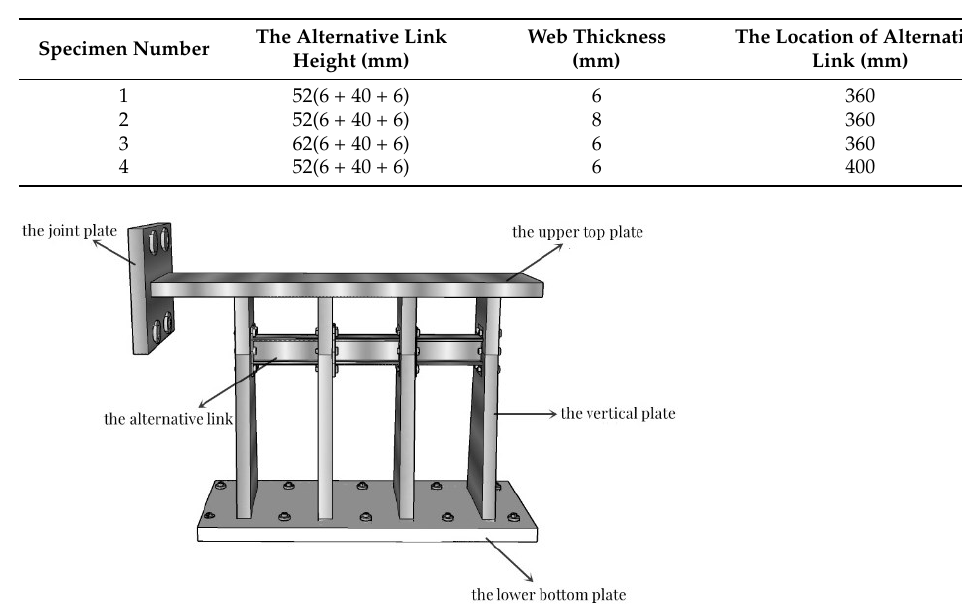
Table 1. Dimension parameters of scaled specimens.